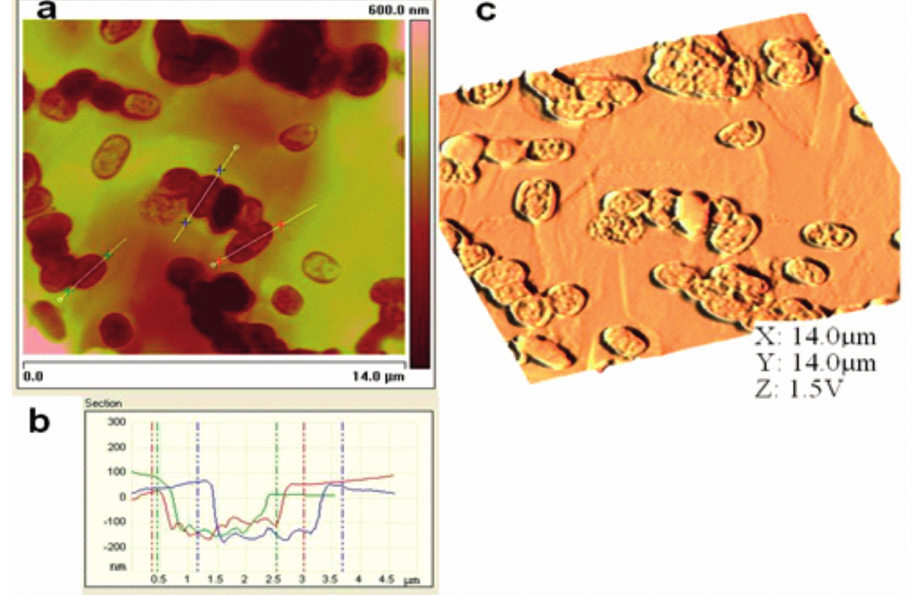
Figure 6. Polyurethane sensitive layer having cavities for reversible inclusion of E. coli , imprinted with a synthetic bacteria stamp (replica of E. coli W) made of